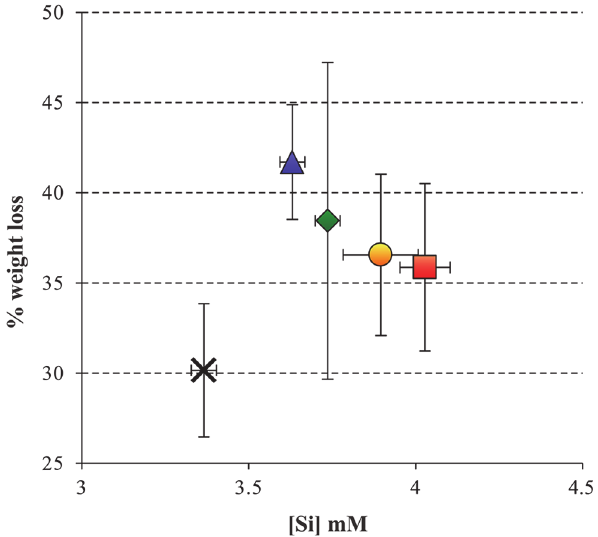
Fig 1. The solubility of phytolith assemblages extracted by dry ashing from modern fresh plant samples. Solubility was determined at pH 10 after the solutions reached saturation with respect to Si. The percentage of weight loss shows that the experimental conditions resulted in partial dissolution of the phytolith assemblages. Error bars indicate 1 σ standard deviation between duplicates. Cross: sedge inflorescence; triangle: reed leaf; diamond: rice inflorescence; circle: palm leaf; square: rice